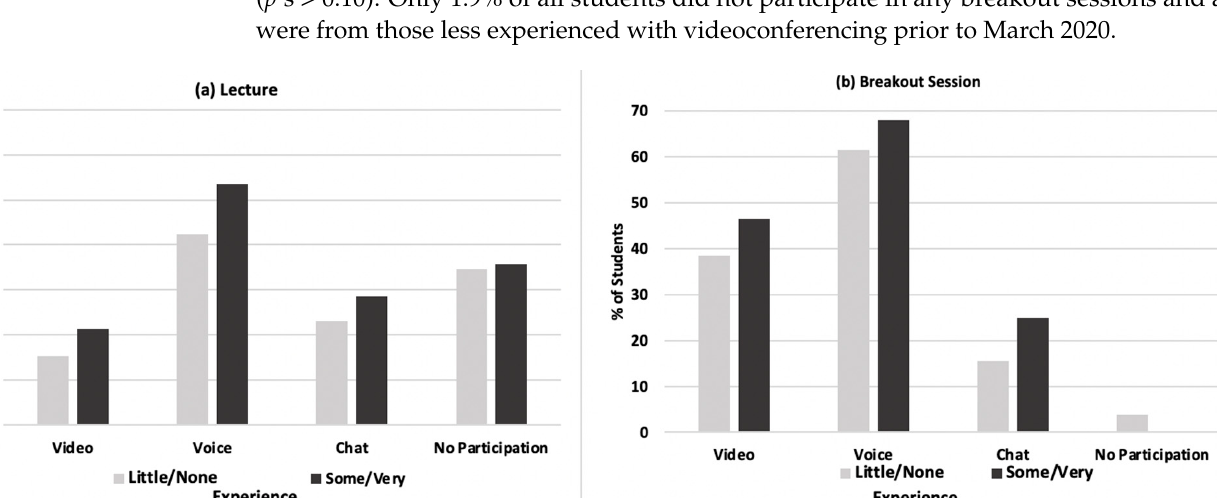
Figure 1. Comparisons of reasons for not using video by experience with video videoconferencing before March 2020 (N = 54). Comparisons performed with independent t -tests.